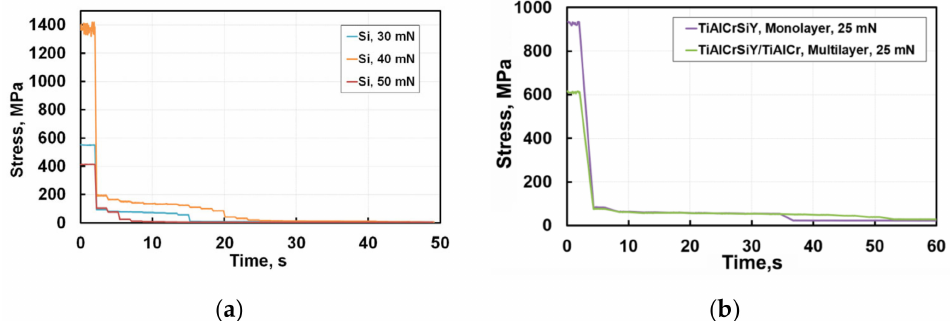
Figure 2. Dependence of stress on the cyclic nanoindentation time at 30–50 mN, 70 s for Si reference ( a ) and at 25 mN, 70 s for monolayer and multilayer coatings ( b